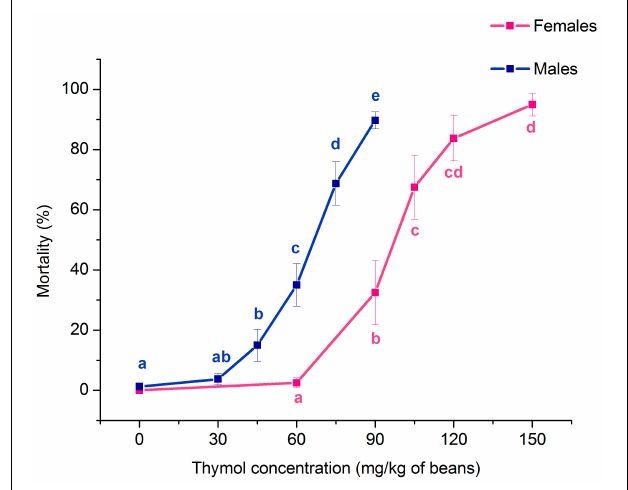
FIGURE 1 | Impact of different concentrations of thymol on Acanthoscelides obtectus mortality after 24 h of exposure to thymol treated bean seeds (means ± SE for 8 replicates). Significant differences among experimental groups within each sex are marked with different letters (a – e) (Duncan’s post-hoc test, p <